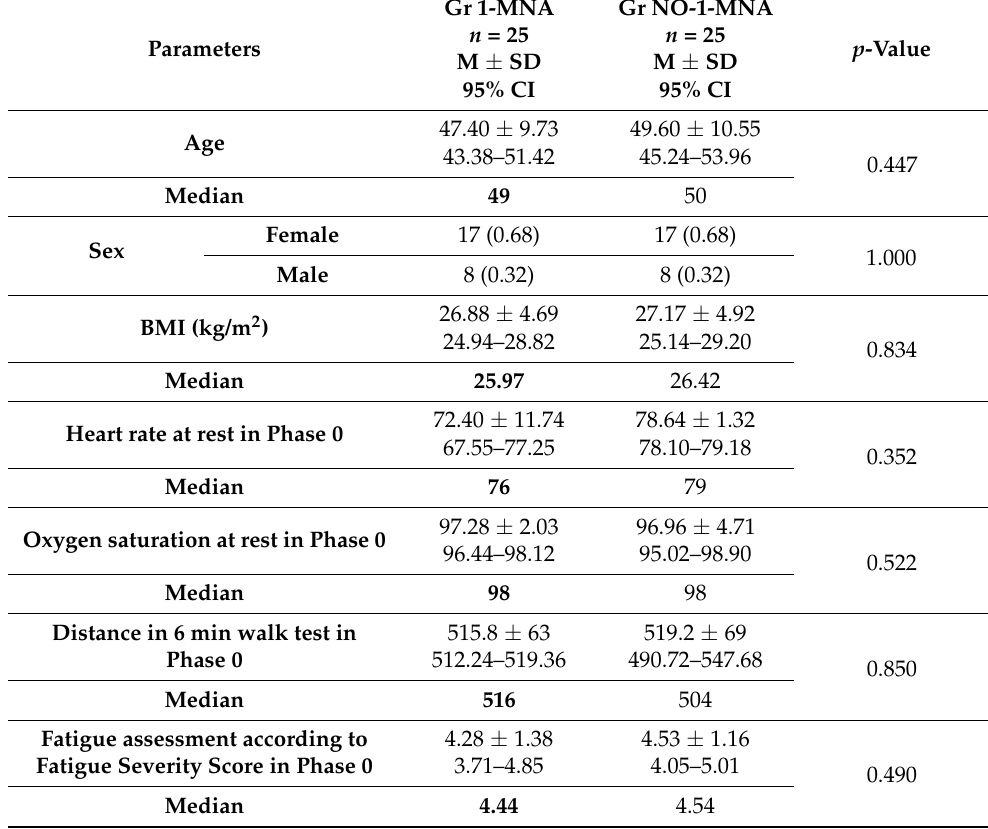
Table 1. Clinical characteristics of the groups Gr 1-MNA and Gr NO-1-MNA at Phase 0.